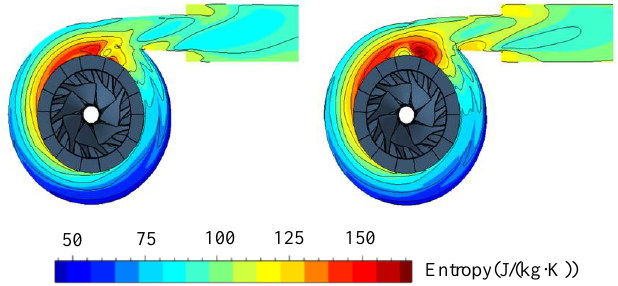
Figure 23. Entropy distribution on the section of diffuser and volute ( left : plain, right : plateau).